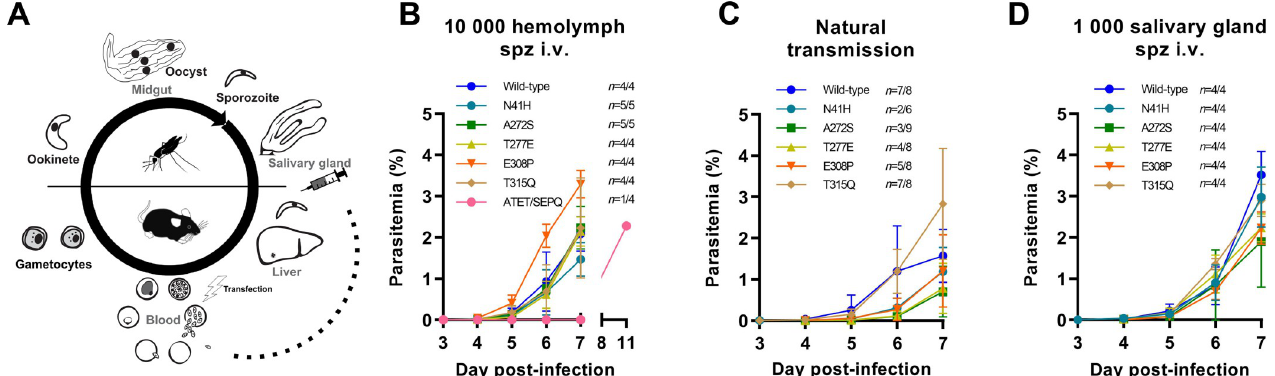
Fig 4. Actin mutants are infectious for new mammalian hosts yet decreased in natural transmission. (A) Schematic representation of the Plasmodium life cycle with relevant stages indicated with a dashed line. Sporozoites are deposited in the skin of a new mammalian host during mosquito probing for a blood vessel. Sporozoites exit the skin through entry into blood capillaries and are transported to the liver where they invade hepatocytes. Sporozoites transform into exoerythrocytic forms within the host cell which releases merozoites into the bloodstream within approximately three days post-infection. (B) Intravenous injection of hemolymph sporozoites indicated that single mutants (which were deficient in salivary gland invasion) infected mice with similar kinetics to the wild-type control and therefore have no major deficiencies in liver invasion or development. ATET/SEPQ was poorly infectious, with only one mouse out of four becoming patent and with a substantial delay. (C) Natural transmission experiments through mosquito bites shows delays and decrease in infectivity testifying to the essentiality of the divergent amino acid residues. This decrease is best interpreted as due to the remarkably reduced loads of salivary gland sporozoites deposited in the skin. (D) Intravenous injection of salivary gland sporozoites results in infection rates and blood stage progression that are very similar to wild-type levels. Data points represented as mean ± standard deviation. n indicates the number of mice positive in relation to the number of mice injected or